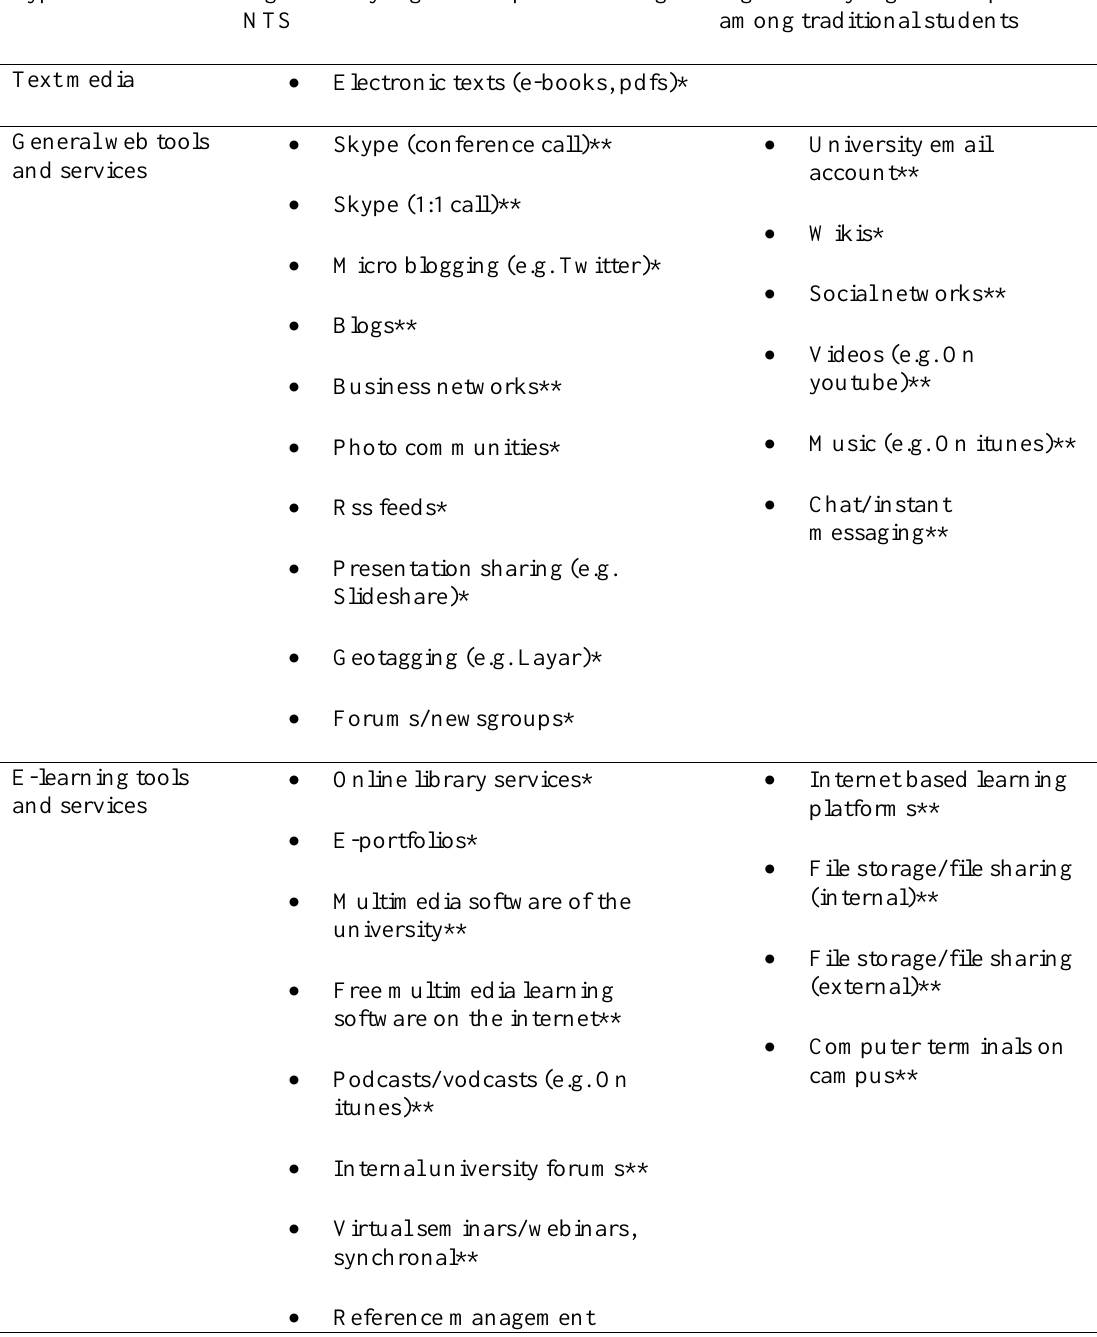
Significantly higher acceptance among traditional students